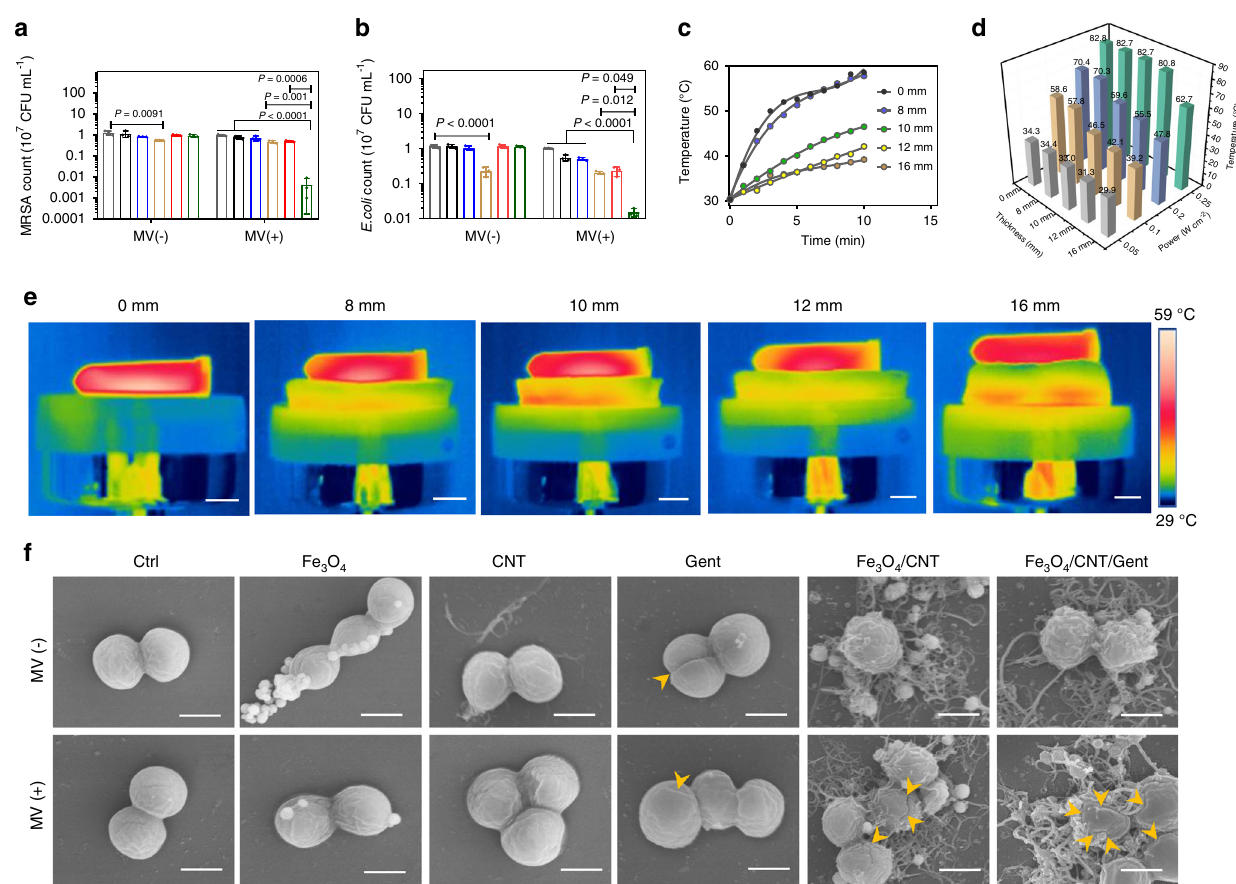
Fig. 5 Evaluation of in vitro tissue penetration depth and antibacterial activity. MRSA ( a ) and E. coli ( b ) strain counts calculated from spread-plate assays after treatment with Fe 3 O 4 , CNT, Fe 3 O 4 /CNT, or Fe 3 O 4 /CNT/Gent (1 mg mL − 1 ) under MV excitation for 20 min or not. c Microwaveocalortic curves of Fe 3 O 4 /CNT/Gent (1 mg mL − 1 ) at different thicknesses of pork tissue (0, 8, 10, 12, and 16 mm) under MV (0.1 W cm − 2 , 10 min) excitation. d Temperature elevations of Fe 3 O 4 /CNT/Gent (1 mg mL − 1 ) on different thicknesses of pork tissue and MV power density via microwaveocalortic